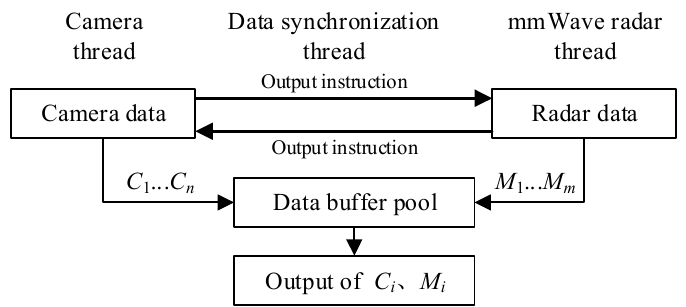
Figure 2. Process of time reference alignment between camera and mmWave radar.